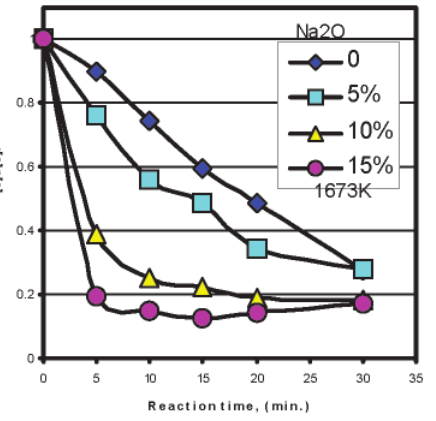
Fig. 7: Effect of TiO 2 in calcium aluminate fluxes on hot metal